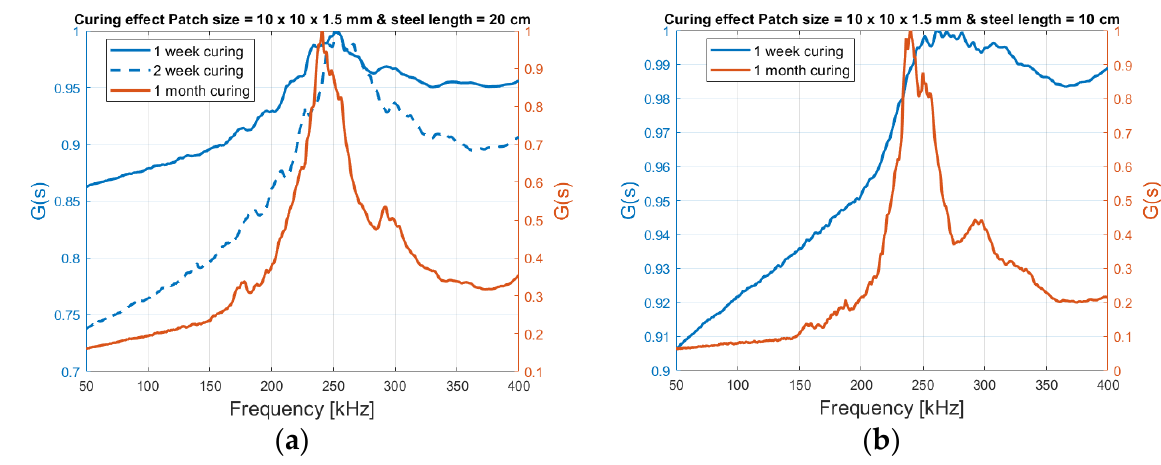
Figure 13. Curing effect on the admittance signature. ( a ) 20 cm long steel beam embedded in concrete with Patch size = 10 × 10 × 1.5 mm; ( b ) 10 cm long steel beam embedded in concrete with Patch size = 10 × 10 × 1.5 mm.